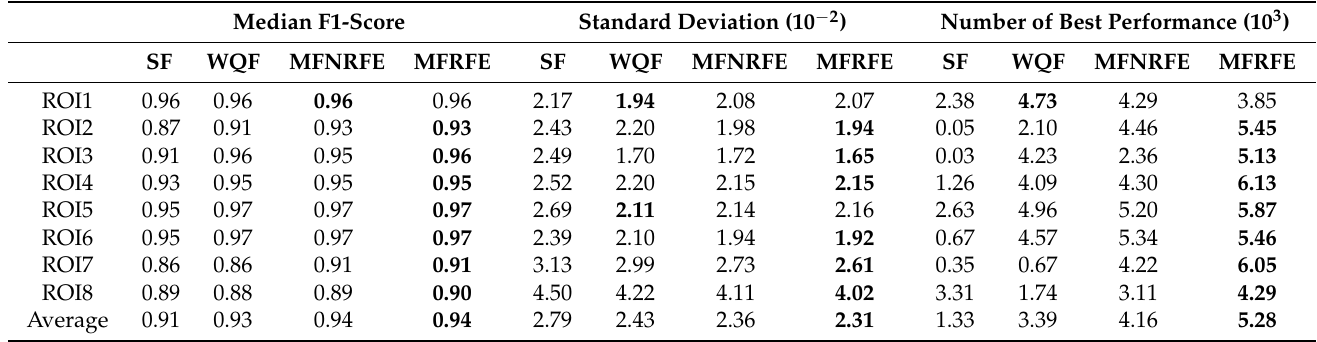
Figure 4. Accuracy verification of four different feature combinations at eight site Models. The southern model is trained on sample data from four sites south of the Yangtze River; the northern model is trained on sample data from four sites north of the Yangtze River. Table 5. The F1M, SD, and NBP of the four test feature combinations at eight test areas (bold numbers indicate optimal feature combination under different assessment